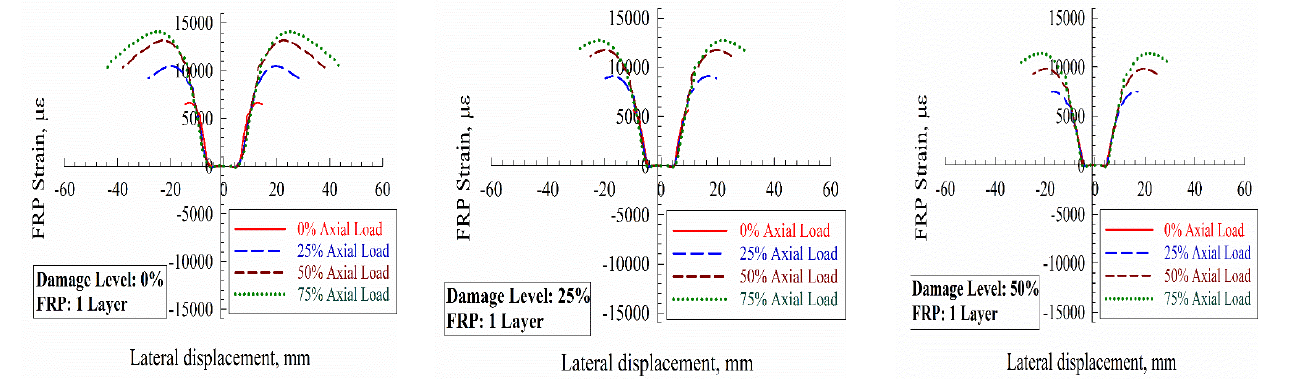
Figure 12. The beam’s reinforcement steel strains.